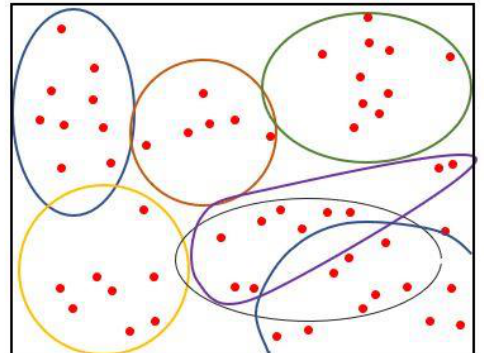
Figure 4 Pattern of point according to each